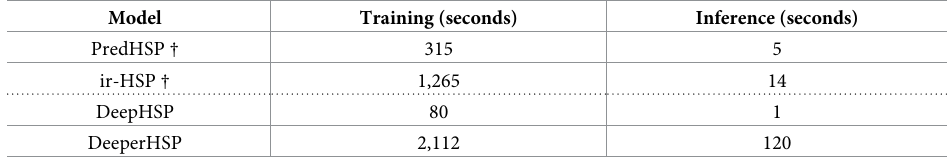
Table 7. Comparison of running time required for each algorithm.